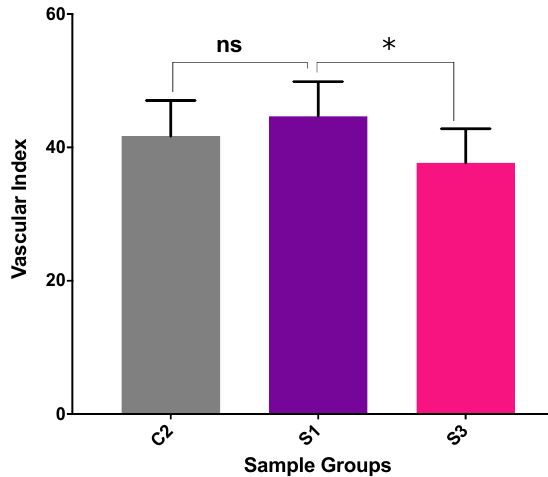
Figure 12. Quantification of angiogenesis on the images taken in the sacrificing day of embryos (day-14) in the following samples: C2: CS.0.1HA; S1: CS.0.1HA.0.005Hep (0.12 mg / mL Hep); S3: CS.0.1HA.0.025Hep (0.60 mg / mL Hep) (ns and * represent the p values which are equal to 0.3482 and